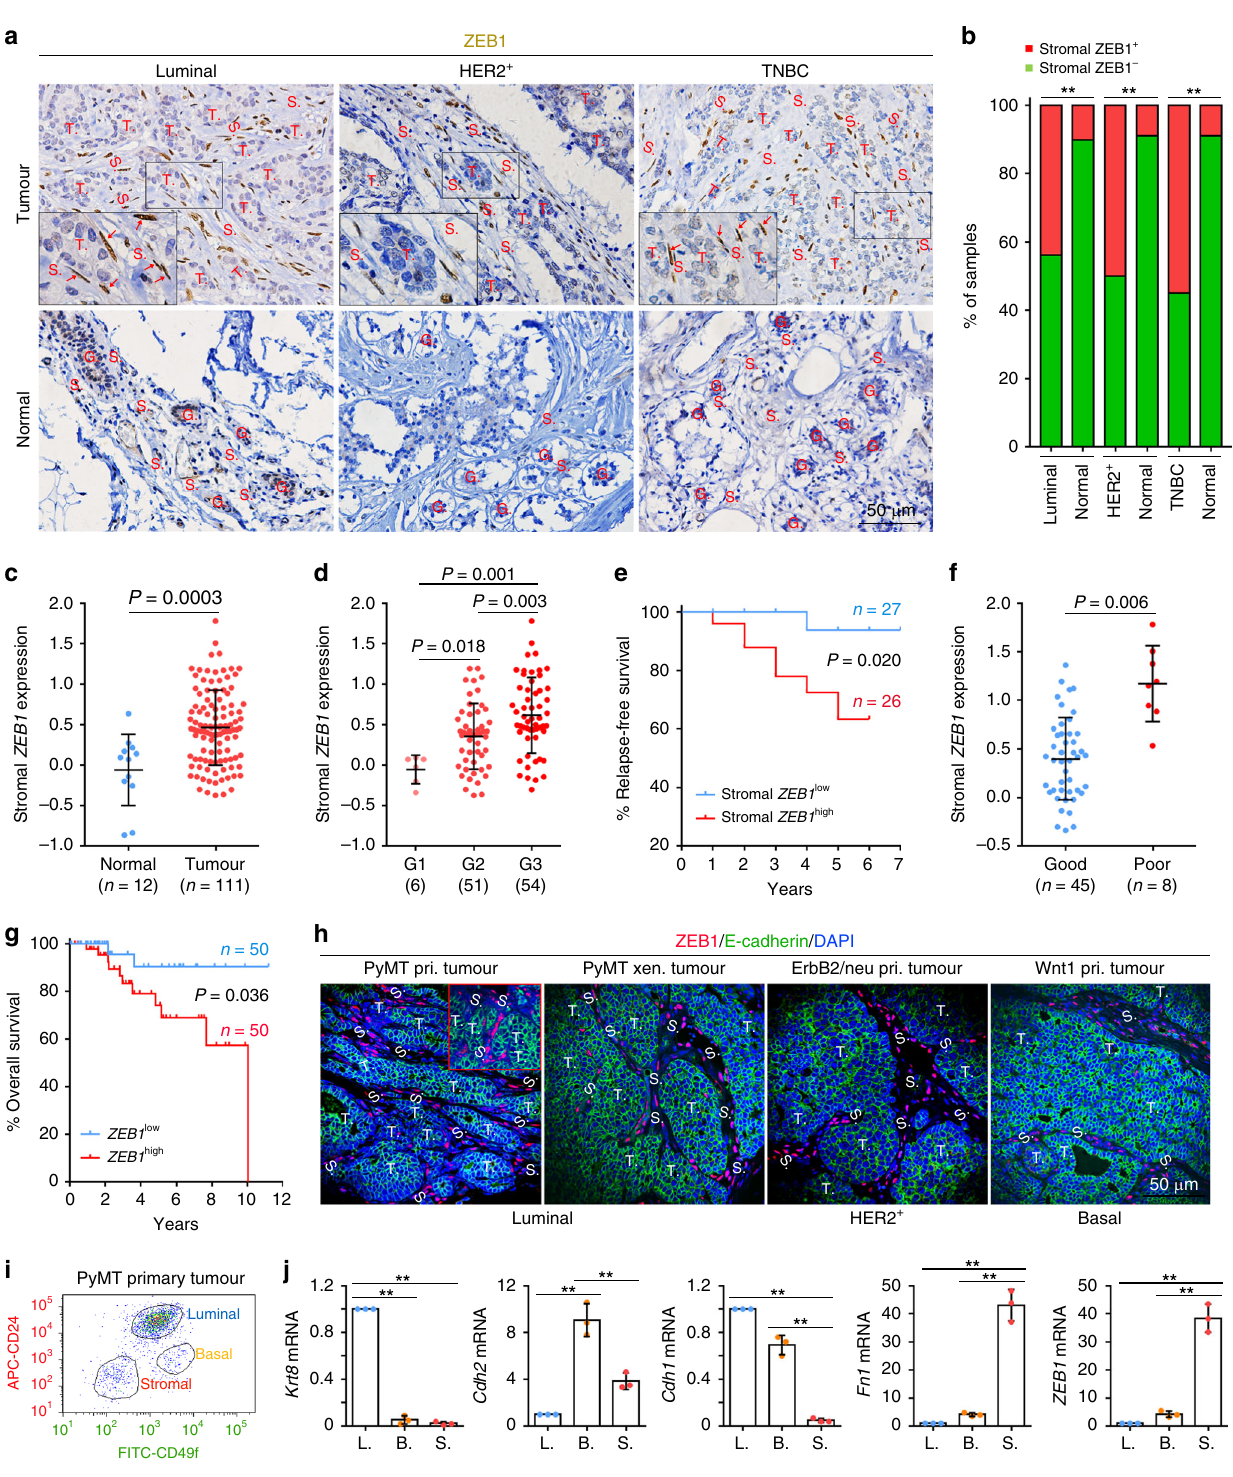
comparable levels of ZEB1 relative to PyMT-Fib-WT tumours (Supplementary Fig. 2i; left panels), suggesting that FSP1-Cre does not target endothelial cells in our system. Of note, we failed to detect ZEB1 protein in CD45-positive leucocytes (including macrophages) in either PyMT-Fib-cKO or PyMT-Fib-WT tumours (Supplementary Fig. 2i; right panels), suggesting that ZEB1 is essentially absent in leucocytes in the MMTV-PyMT model. Interestingly, we found that stromal CAFs remained